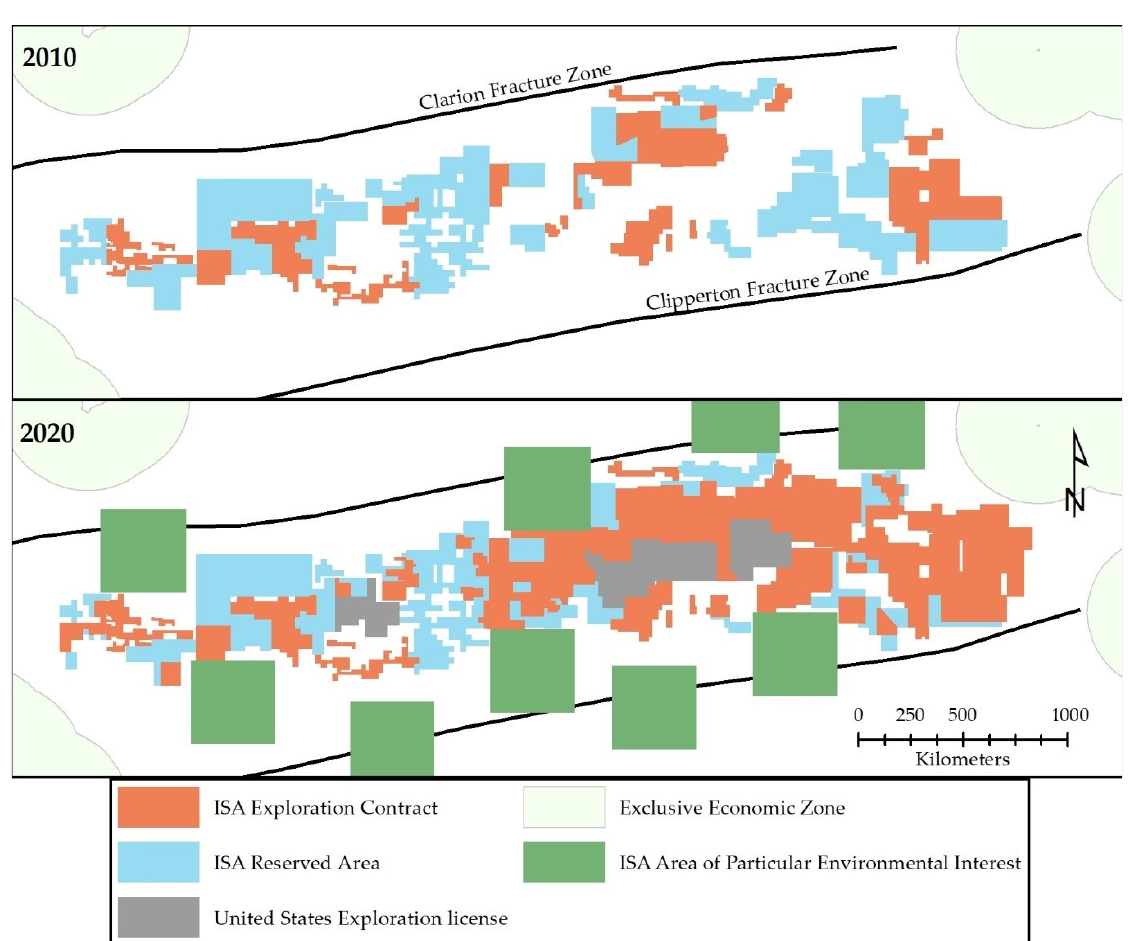
Figure 2. Growth in seabed claims in the CCZ. Sources: International Seabed Authority (ISA) [13], National Oceanic and Atmospheric Administration [11], and Marine Regions